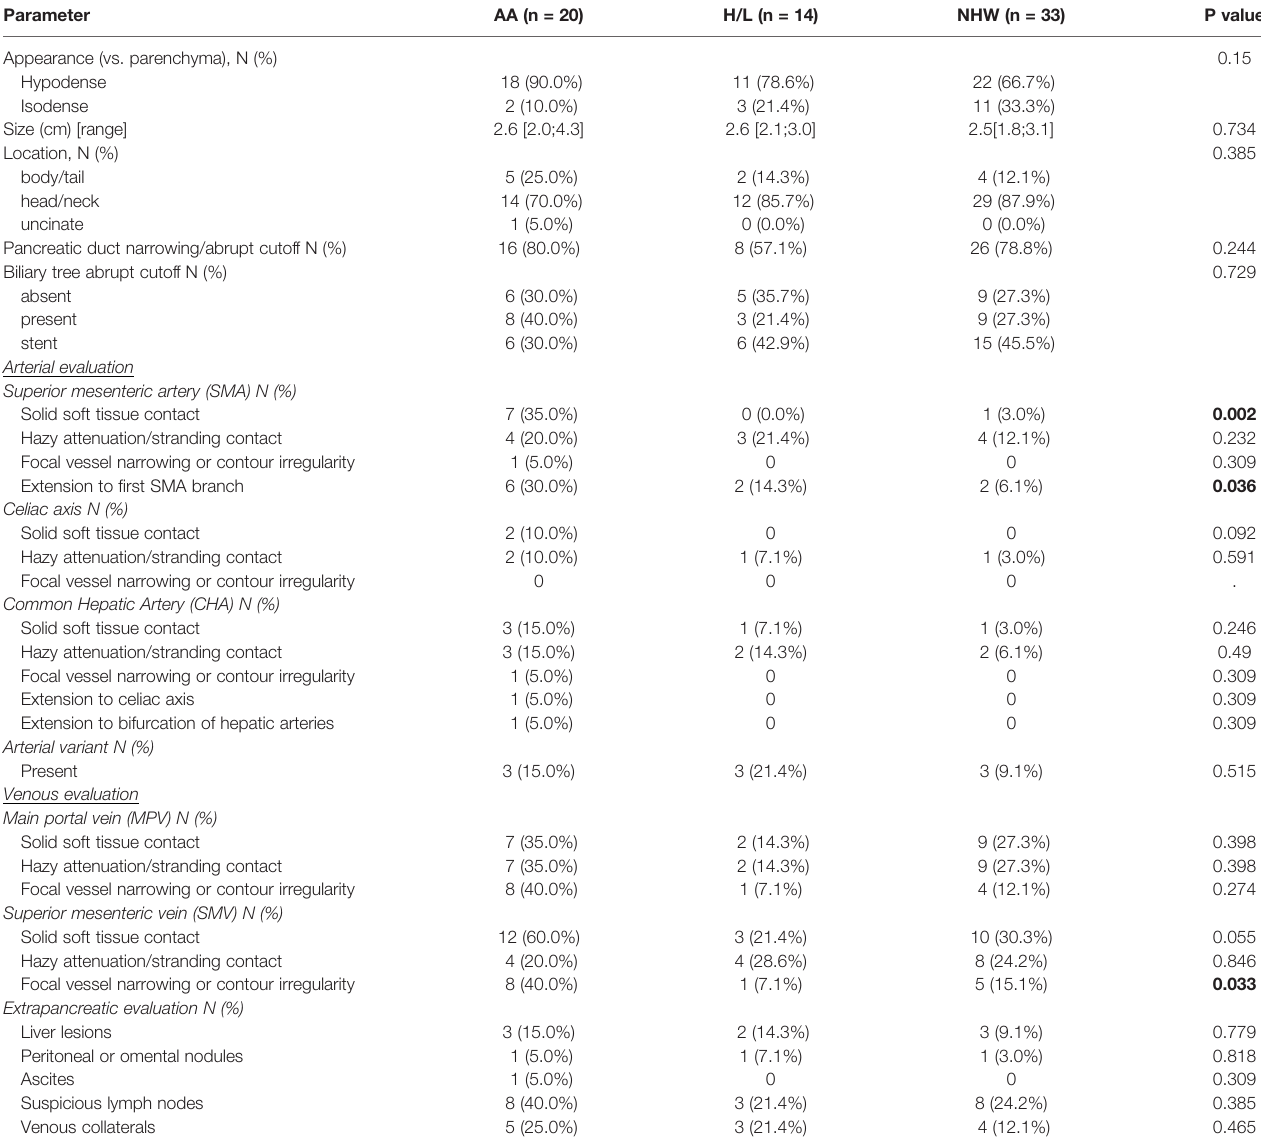
TABLE 3 | PDAC radiologic reporting template parameters for the study cohort. Parameter Appearance (vs. parenchyma), N (%)